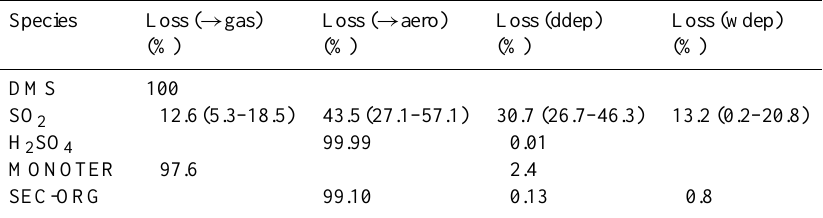
Fig. 2. Simulated (solid lines) and observed (plus symbols) annual cycle of (a) DMS and (b) SO 2 at Amsterdam Island (Nguyen et al., 1992); (c) DMS and (d) SO 2 at Cape Grim (Ayers et al., 1991); (e) DMS at Dumont D’Urville (Jourdain and Legrand, 2001). Normalised mean bias ( b ) and Pearson regression coefficient ( R ) are shown in each panel. Model values are monthly-mean volume mixing ratio in the lowest model level. Panel (d) also shows model surface SO 2 at 1 (dotted), 2 (dashed) and 3 (dot-dashed) gridboxes to the South of Cape Grim). Table 5. Annual mean global removal fluxes as a percentage of total removal for each of the simulated gas phase aerosol precursors. For SO 2 , the range as simulated in 14 previous global model studies (see Spracklen et al., 2005) is included in